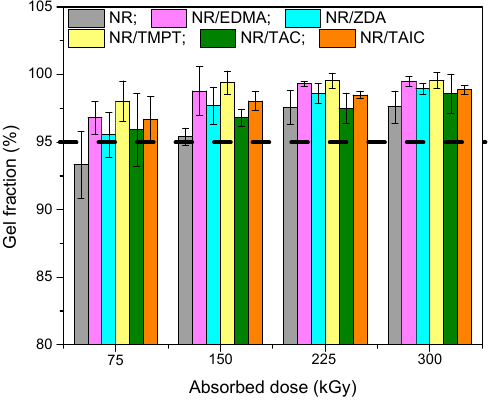
Figure 1. Effects of the absorbed dose and PFMs on gel content.